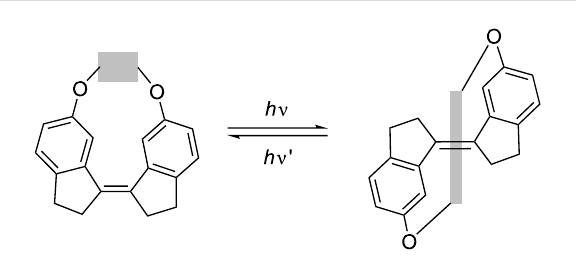
Scheme 3: The photoisomerization of the stiff stilbene macrocycles, showing the stretching of the linker (grey box).